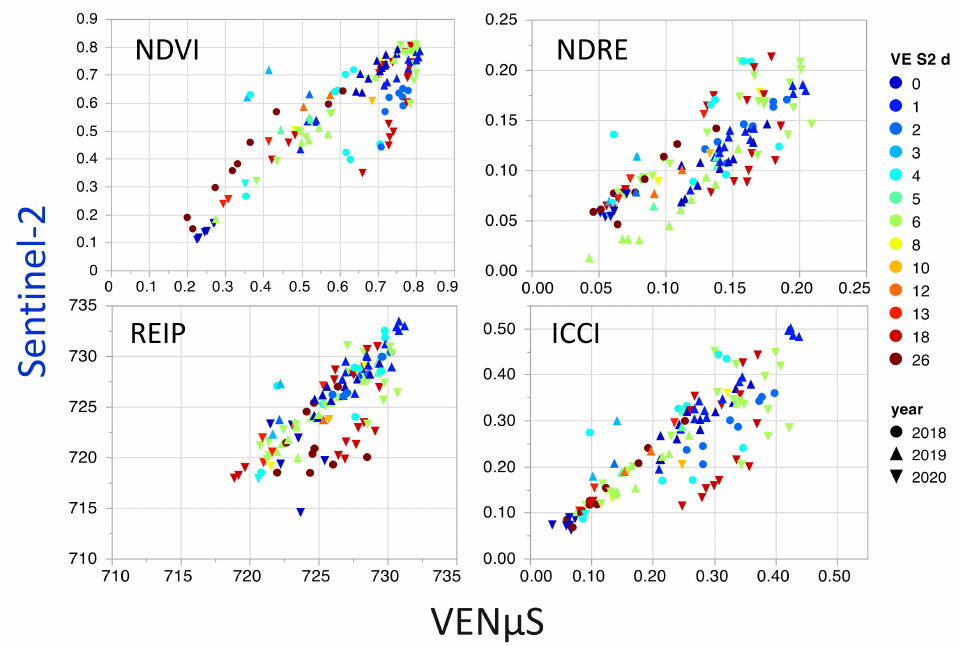
Figure 6. Correlation between VEN µ S and Sentinel-2 vegetation indices, as retrieved from wheat fields during 2018–2020. Symbols represent season and colors represent the difference in the number of days between VEN µ S and Sentinel-2